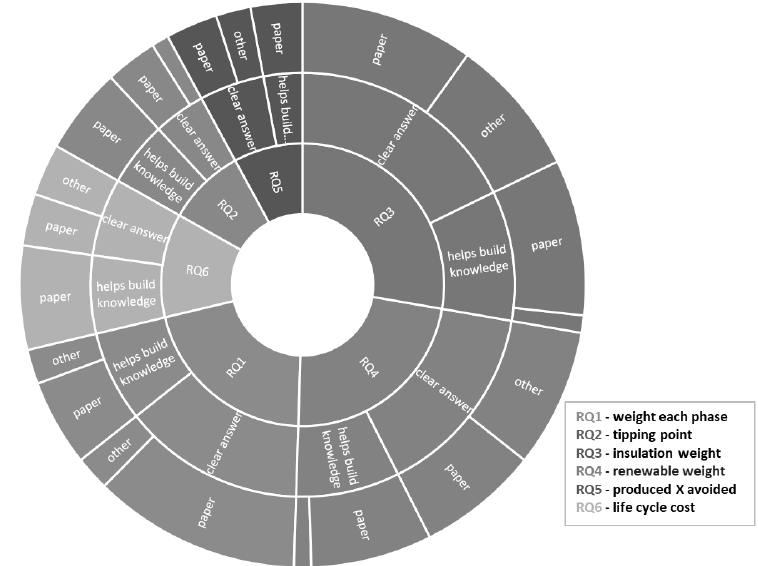
Figure 3. Overview of studies assessed and the amount and type of studies answering the research questions.